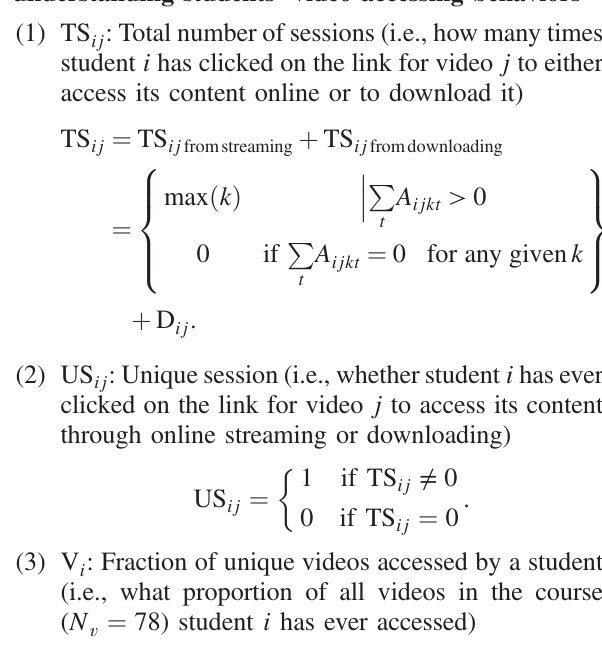
TABLE IX. Example made-up data explaining how events would be recorded in clickstream (the first 3 columns) and how matrix A ijkt would be constructed (the last 2 columns) for the following scenario: A student watched the first 40 seconds of a video, and then (without clicking on “ pause ” first) clicked on the scrubber below the video to jump to the point that corresponds to 100 s in in-video time. Since the pause button had not been clicked, the video would automatically continue playing from t ¼ 100 s. The student then continued watching the video for another 20 seconds. In our study, we assume that the real-time it takes for the video to jump from